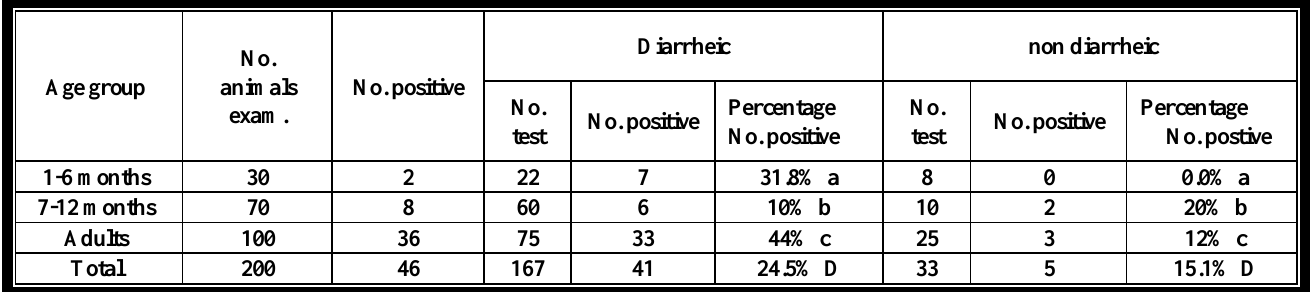
Table ( 1 ) Age wise Prevalence of cryptosporidiosis in Diarrheic and non Diarrheic calves .